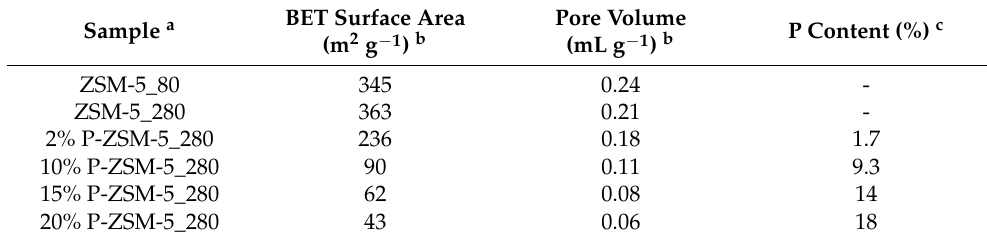
Table 8. Physical properties of ZSM-5 and P-ZSM-5_280.